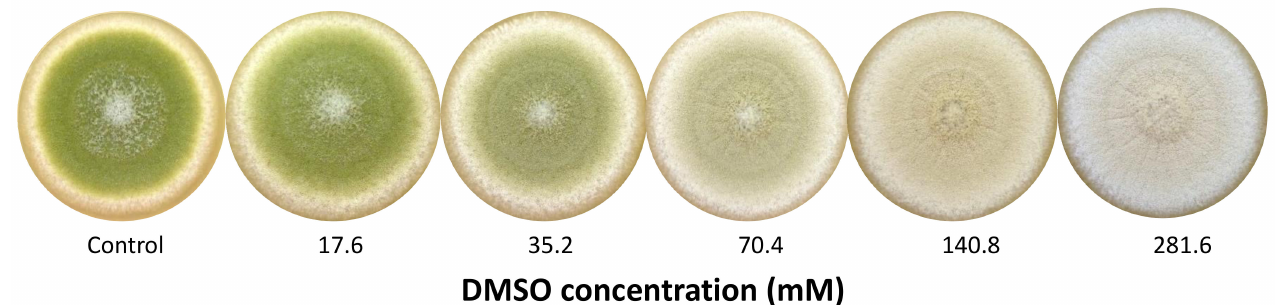
Figure 1. Macroscopic aspect of 8-day cultures of Aspergillus flavus NRRL 62477 in response to increasing dose of DMSO